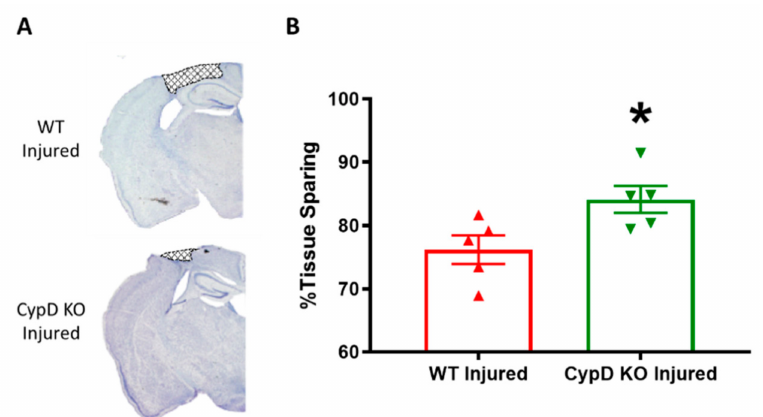
Figure 3. CypD knockout increases tissue sparing following TBI. ( A ) Representative coronal brain sections displaying lesion area (bregma level − 1.4 mm). ( B ) Quantitative assessment of tissue sparing to WT animals. * p = 0.033. Data points represent group mean ± SEM. N =